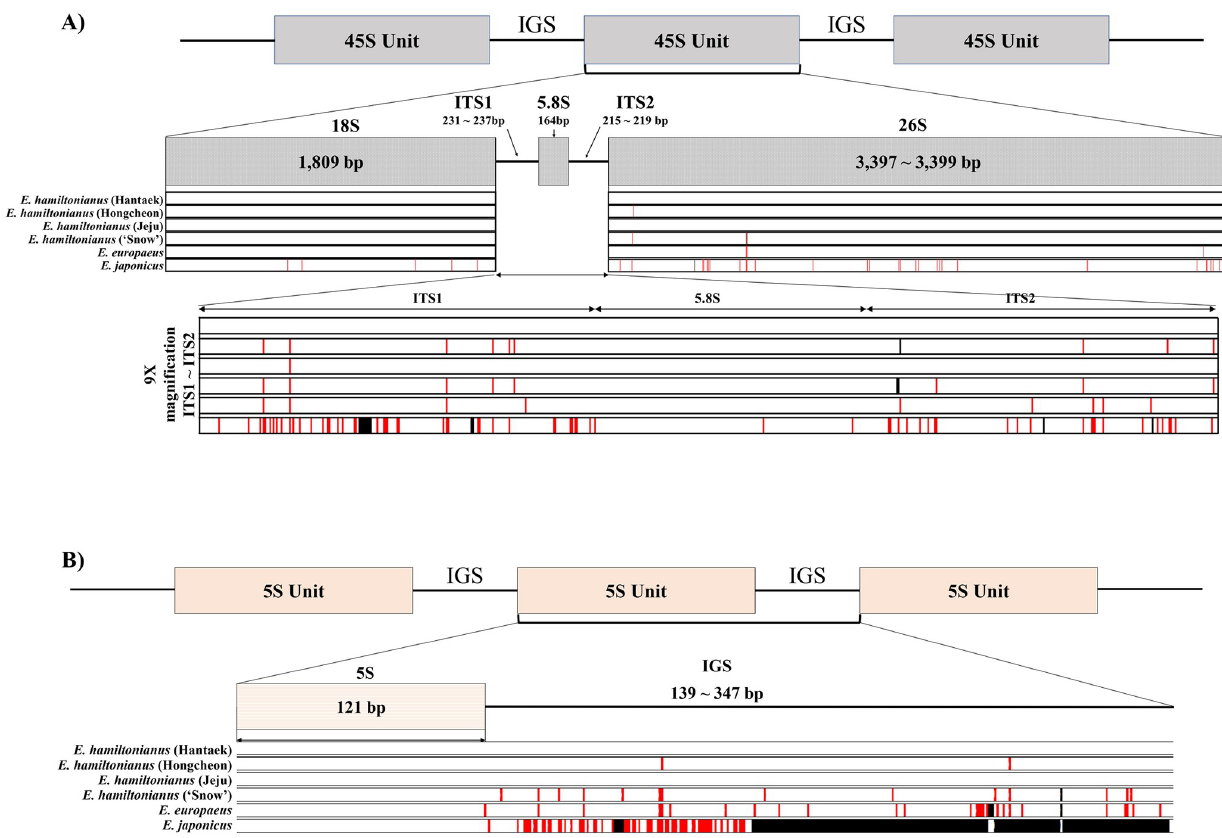
Fig 2. Genomic structures and diversity of rDNAs in Euonymus . A and B show the structures of 45S rDNA and 5S rDNA, respectively. Variations are marked based on E . hamiltonianus (Hantaek) as a reference and are highlighted by red and black lines. Red and black lines indicate SNPs and InDels,